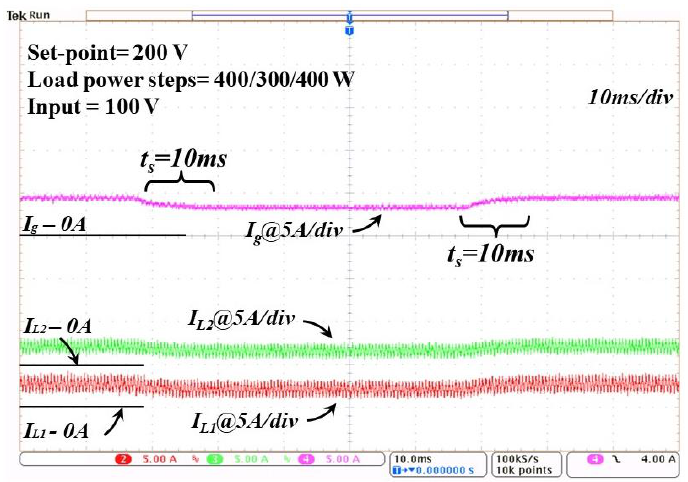
Figure 30. Closed-loop test, the output power Po changes from 400 W to 300 W and then, it increases back to 400 W again, Vo is regulated to 200 V . Figure 31 shows the prototype photo.